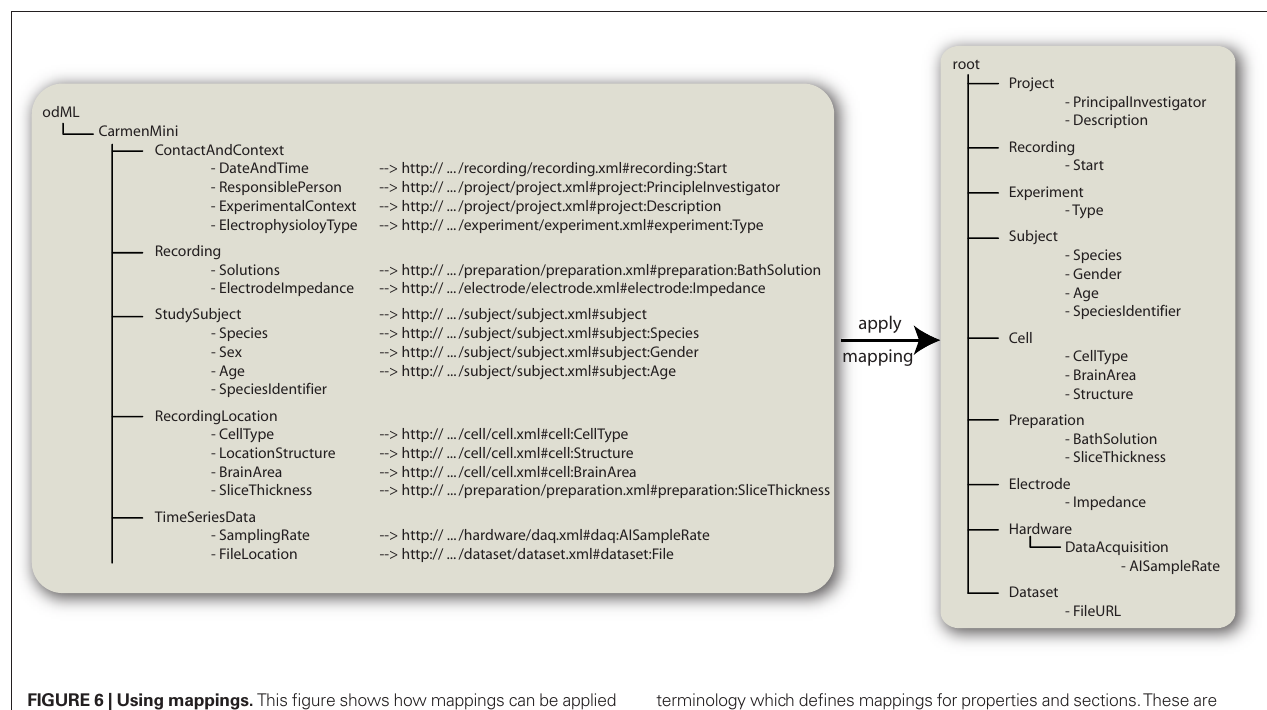
Figure 6 | using mappings. This figure shows how mappings can be applied to convert a metadata tree from one layout to another. The left panel shows metadata that are organized as suggested by the CARMEN “Mini” metadata standard. The metadata file is in the od ML format and refers to the CarmenMini